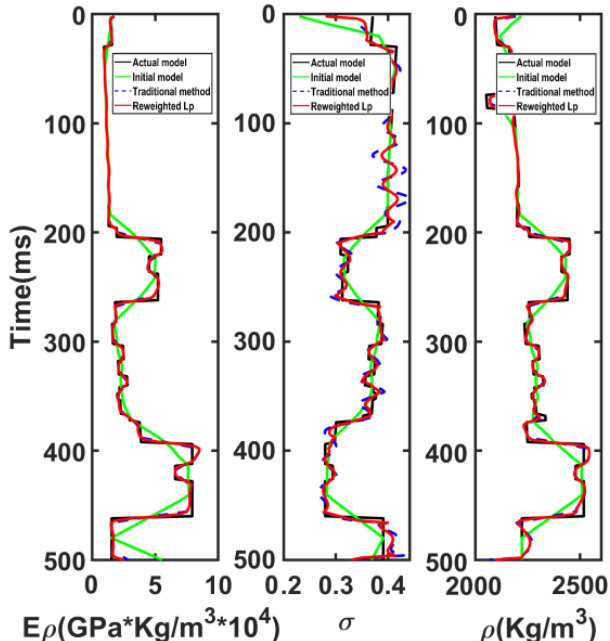
Figure 21. Comparison of inversion results for the 150th trace after adding noise.